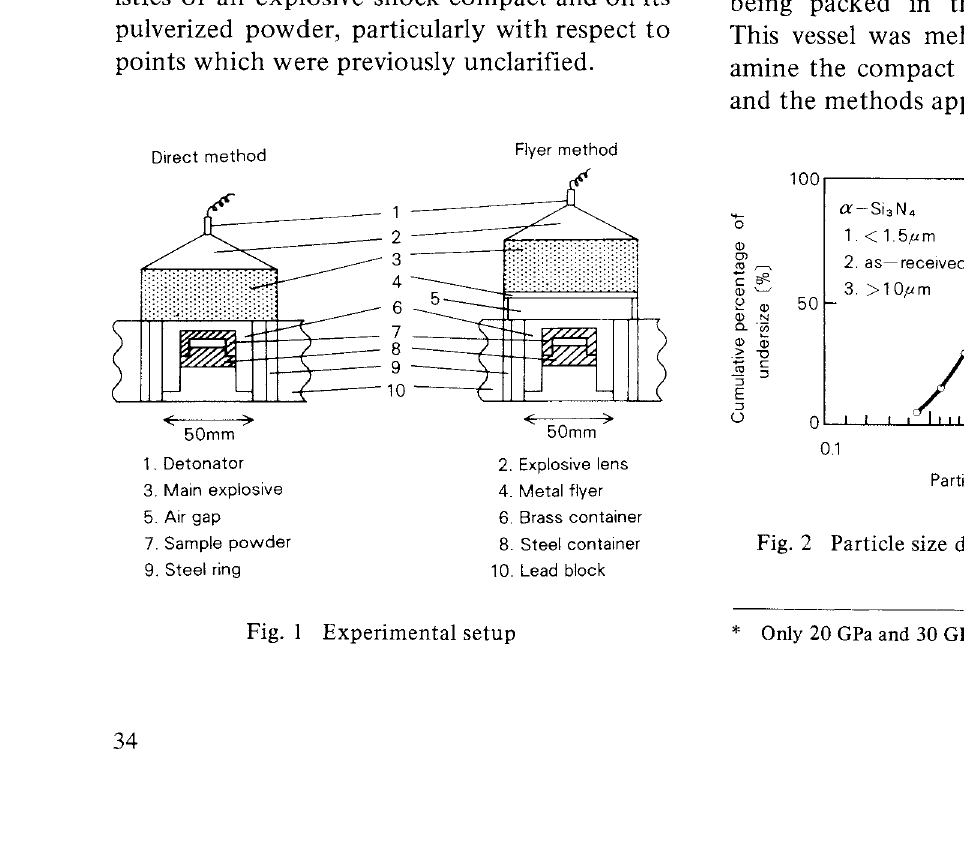
Fig. 2 Particle size distribution of sample